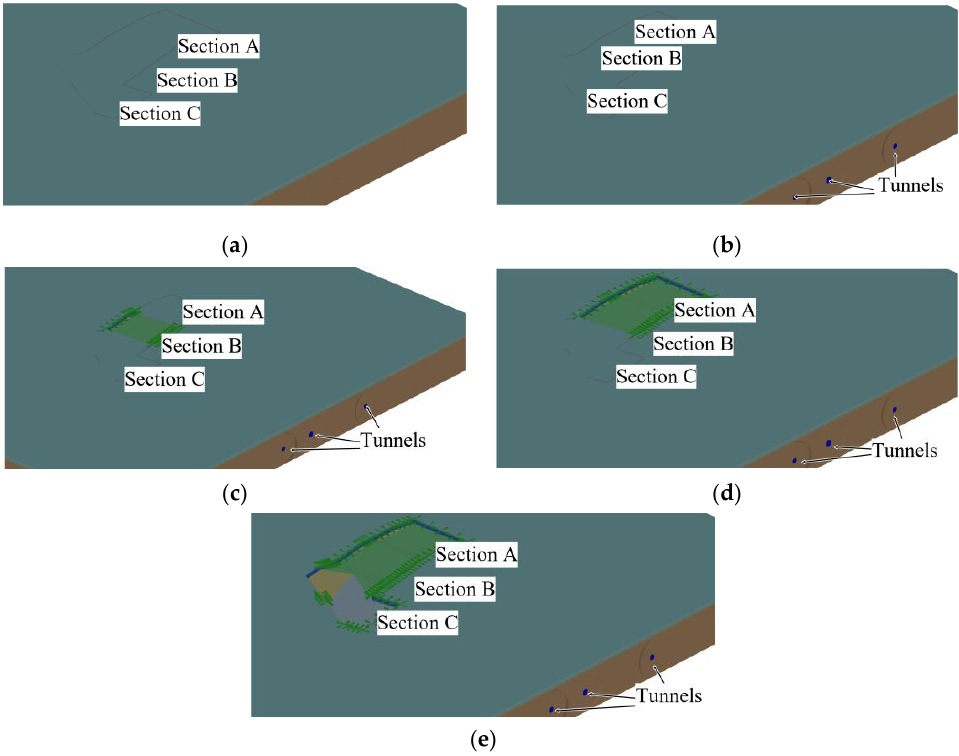
Figure 8. Simulation stages: ( a ) stage 1: earth stress equilibrium, ( b ) stage 2: tunnel excavation, ( c ) stage 3: section B excavation, ( d ) stage 4: section A excavation, ( e ) stage 5: section C excavation.